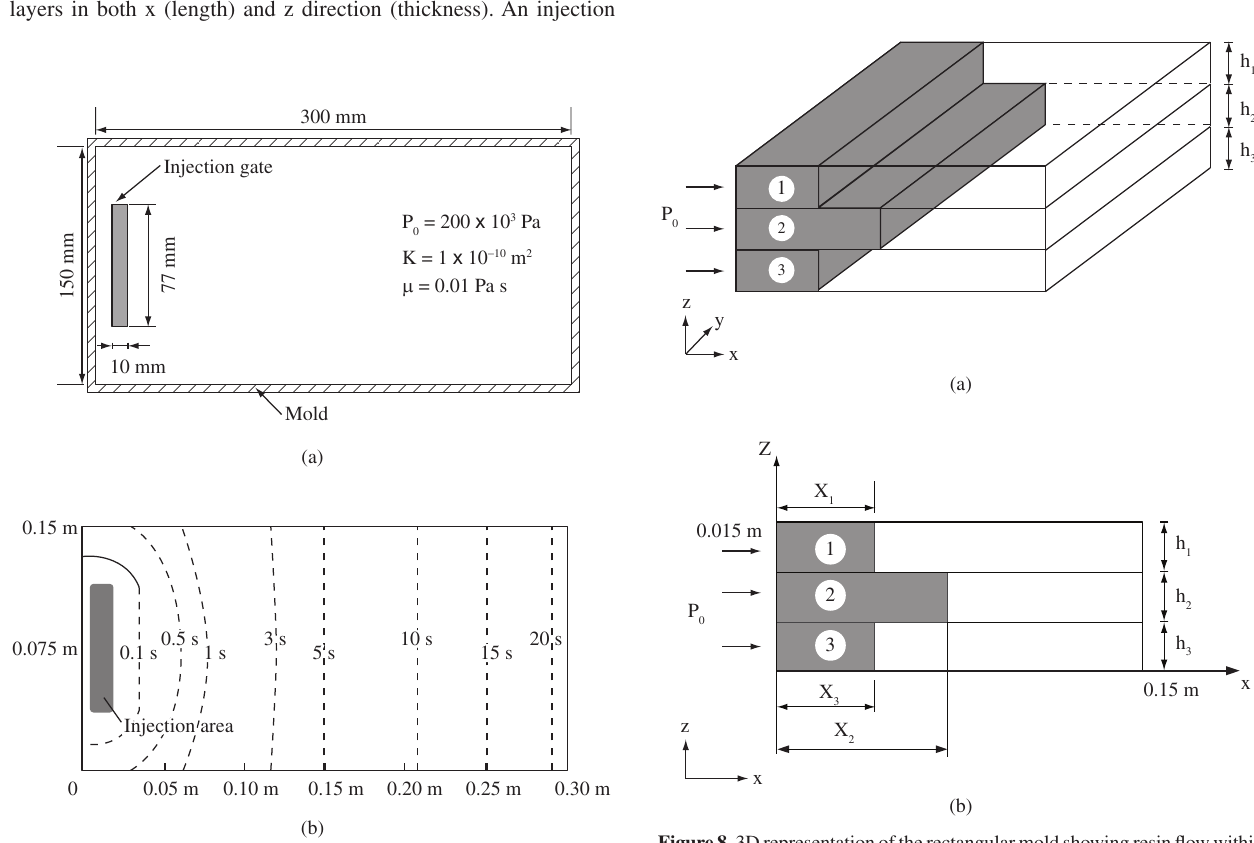
Figure 7. Mold filling simulation: a) Problem sketch, and b) Flow-front at different injection times.